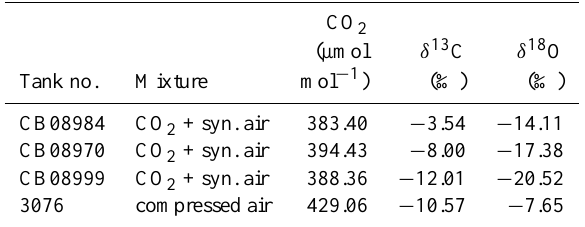
Table 1. Primary standards with the assigned values on the WMO- X2007 scale for CO 2 and the VPDB-CO 2 scale for δ 13 C and δ 18 O as determined in spring 2012.